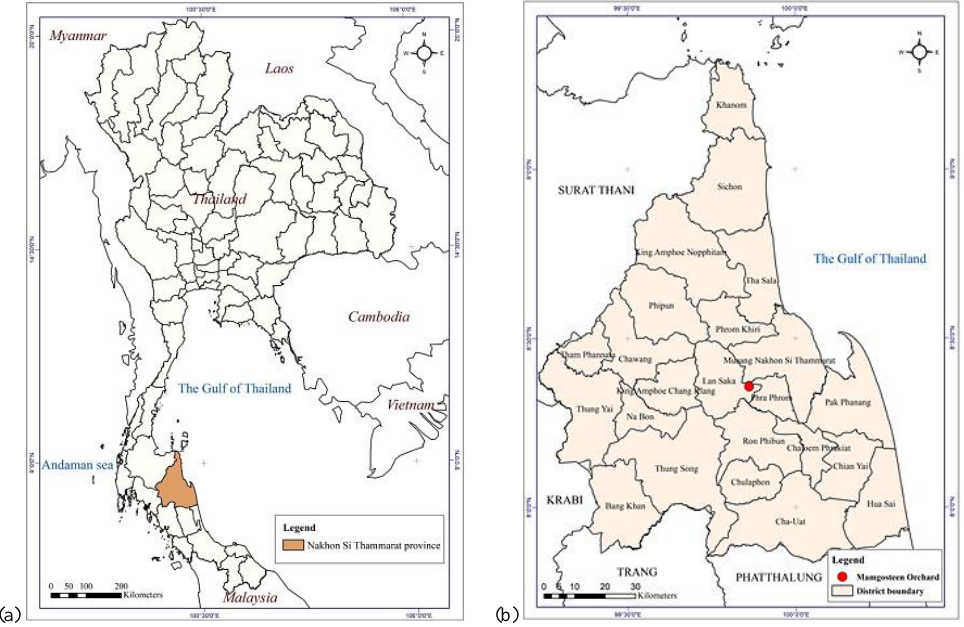
Figure 2. (a) Thailand map with Nakhon Si Thammarat Province in shaded color and (b) Nakhon Si Thammarat Province map with Mangosteen orchard location in a red